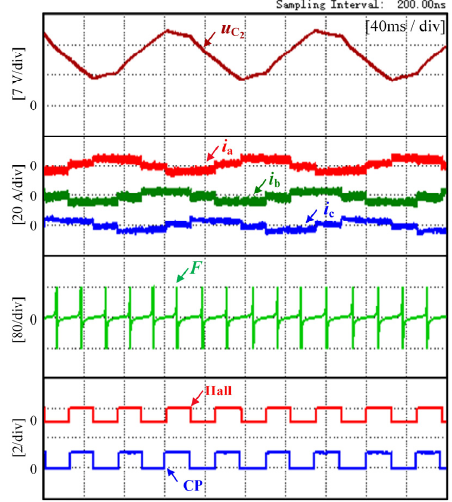
Figure 13. Experimental waveform under the condition of 100 r/min speed and 0.8 N·m torque.